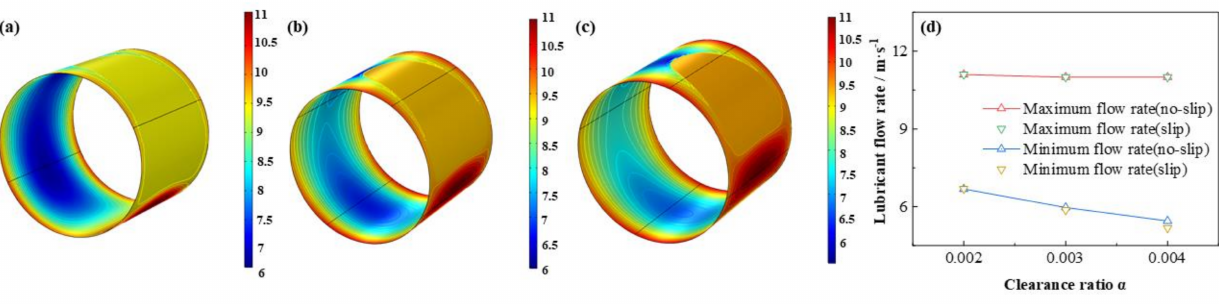
Figure 25. Comparison of the flow rate distribution under different clearance ratios. ( a ) α = 0.002; ( b ) α = 0.003; ( c ) α = 0.004; ( d ) maximum/minimum flow